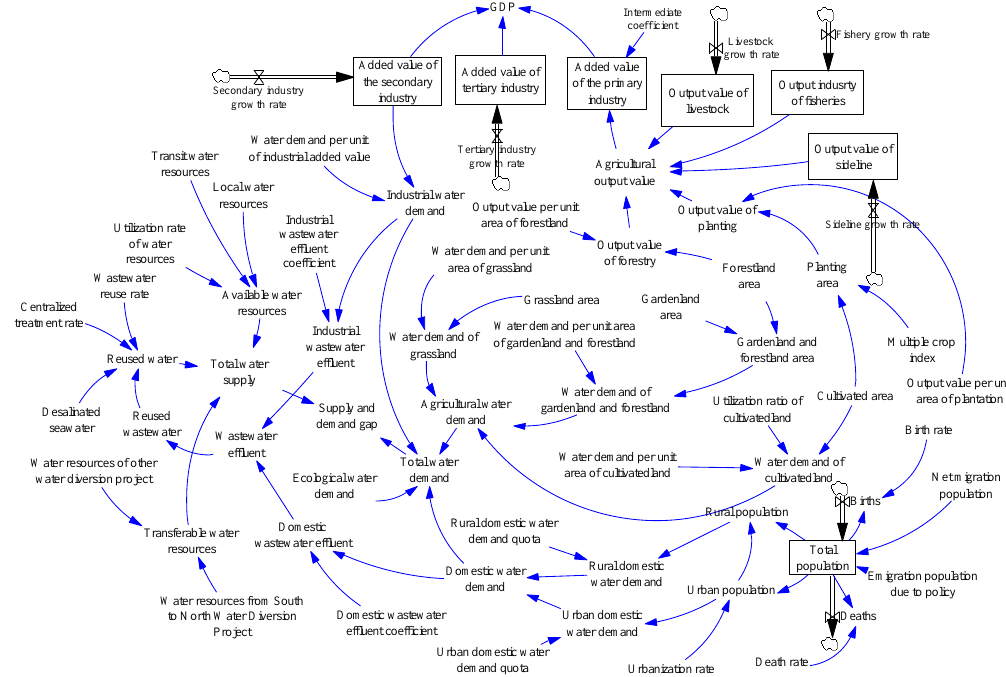
Figure 3. Stock and flow diagram of system dynamics model of urbanization development and water scarcity.